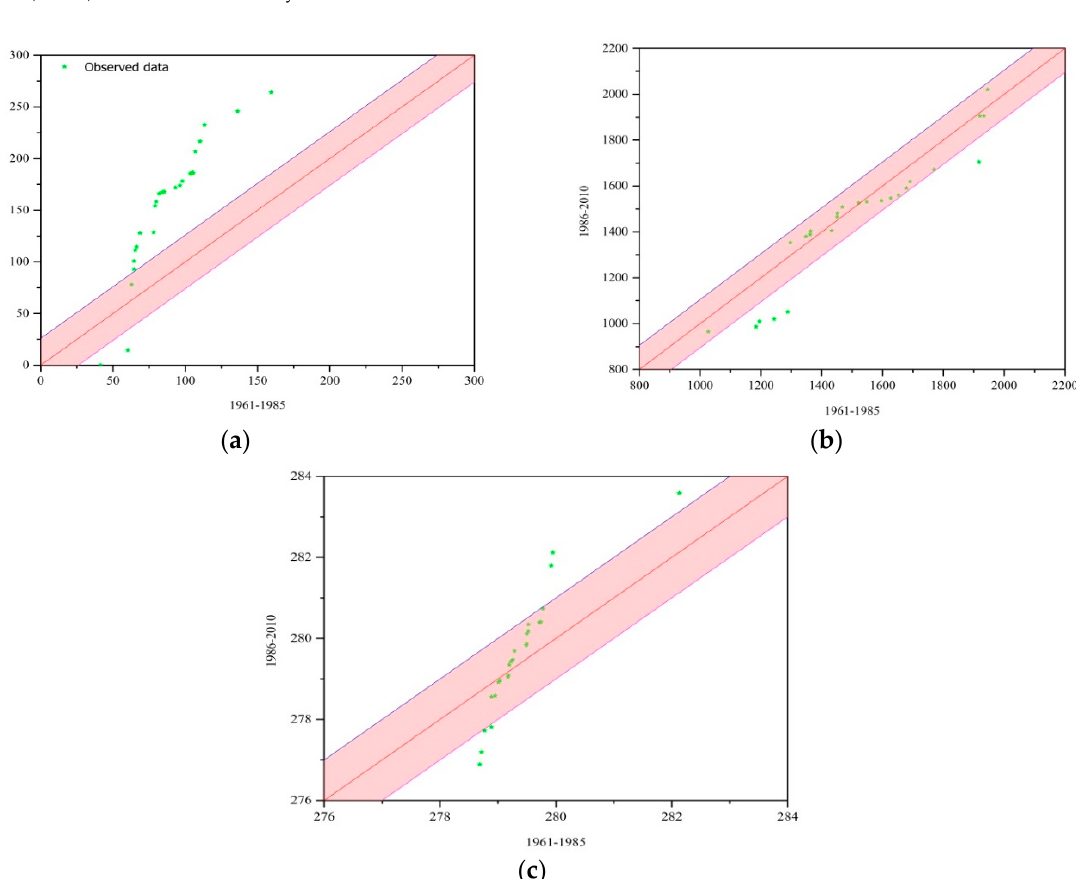
Figure 8. Annual innovative trend analysis (ITA) statistics for precipitation, runoff and temperature for Zone II. ( a ) precipitation, ( b ) runoff, ( c ). temperature